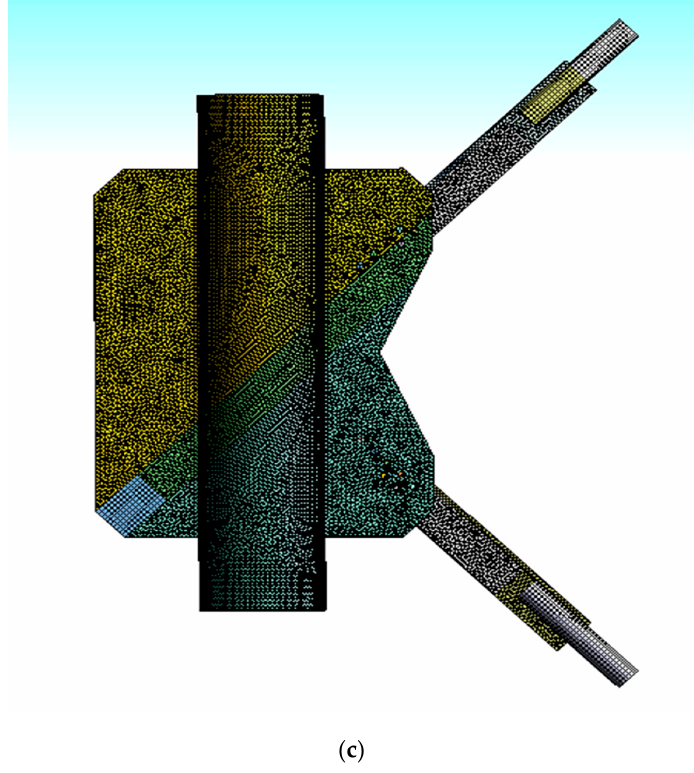
Figure 15. ( a ) Finite element model of PDLDPJ; ( b ) loading diagram of PDLDPJ; ( c ) meshing dia- gram of PDLDPJ.